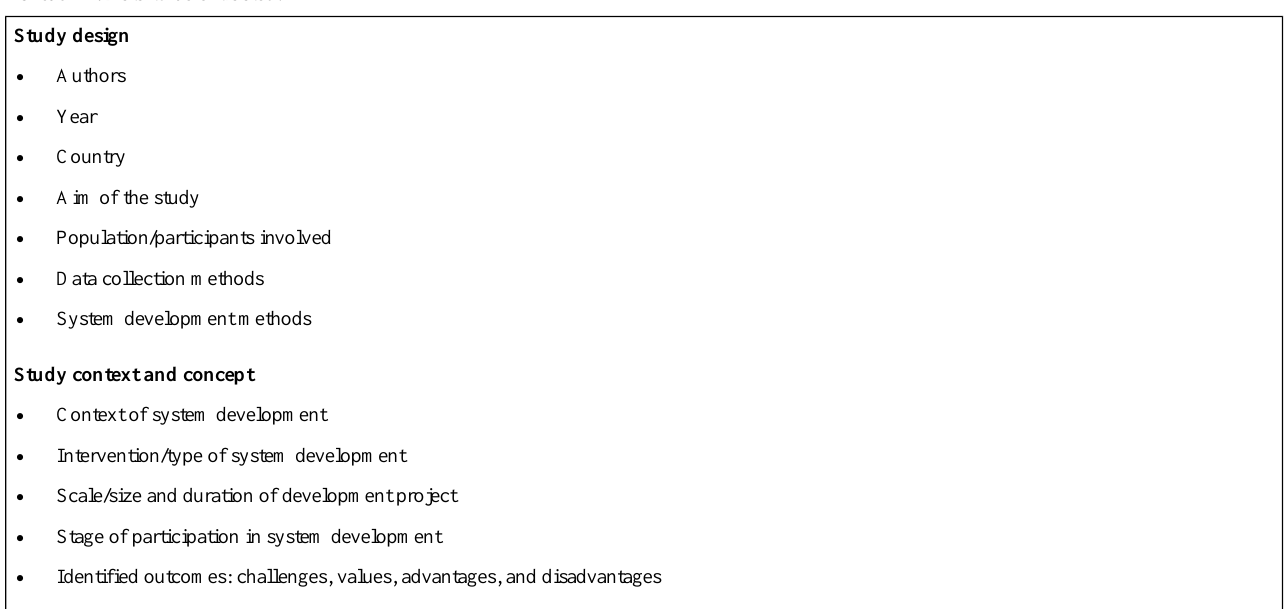
Results on ScopusResults on MEDLINEQuerySearch